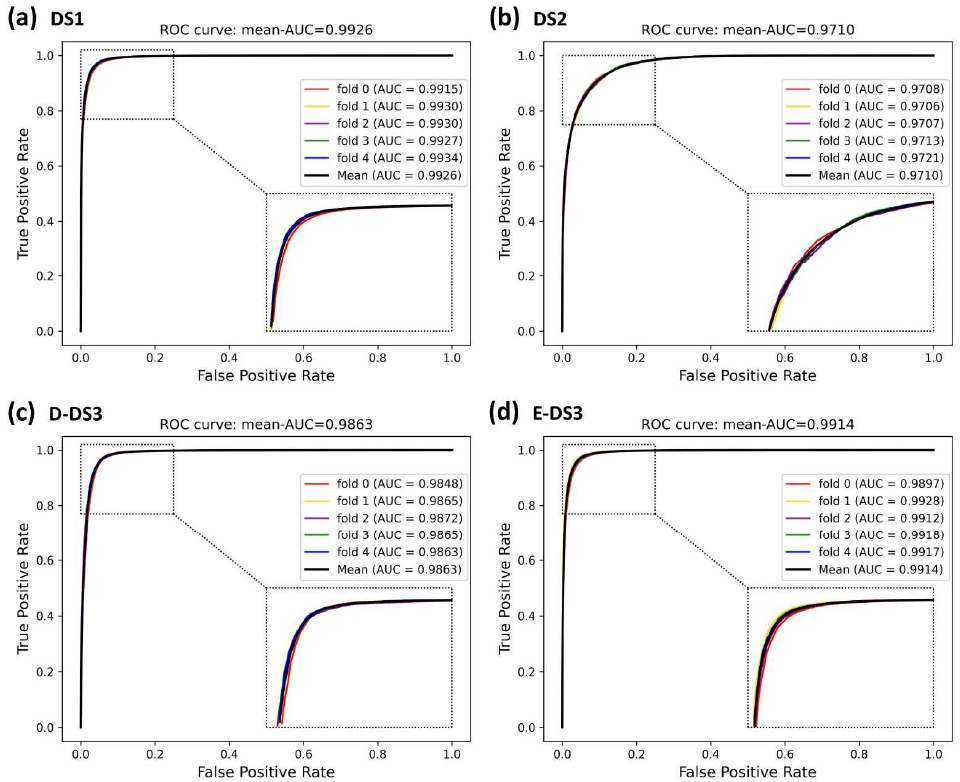
Figure 5. ROC curves of the five-fold cross-validation on the four datasets by the proposed method, BioChemDDI.